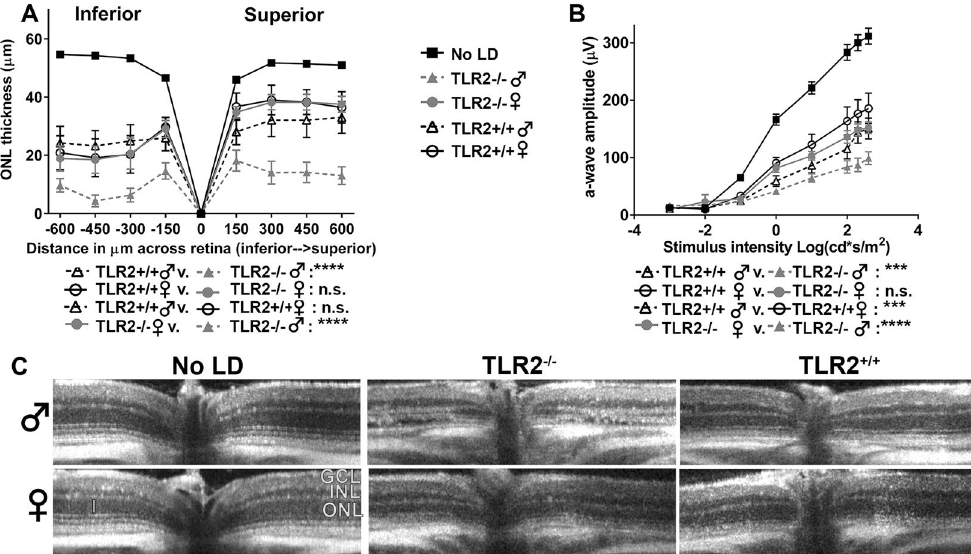
Figure 3. TLR2 − / − mice have increased susceptibility to light damage (LD). ( A ) Thickness of the photoreceptor layer (ONL) in TLR2 − / − and TLR2 + / + mice are plotted versus the distance from the optic nerve head (0 point). Thicknesses from male and female mice are plotted separately for each genotype. Measurements were made following LD. Plots from mice not subjected to light damage (No LD) are shown for comparison. ( B ) Scotopic ERG a-wave amplitudes are plotted versus intensity of light stimulation. Analysis of males and females are shown separately following light damage. ( C ) Representative OCT b-scans that were used to quantify retinal thickness shown in A. P values are from two-way ANOVA with a Sidak correction for multiple comparisons. n = 8–13 total from 3 independent